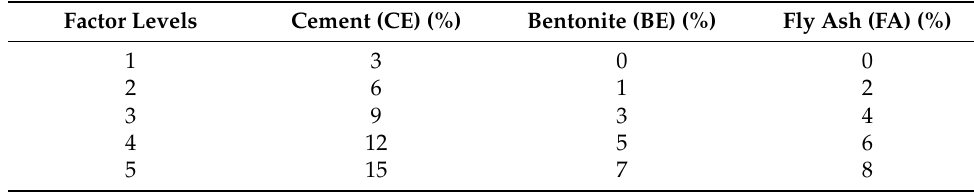
Table 3. The orthogonal experiment (Wt%).